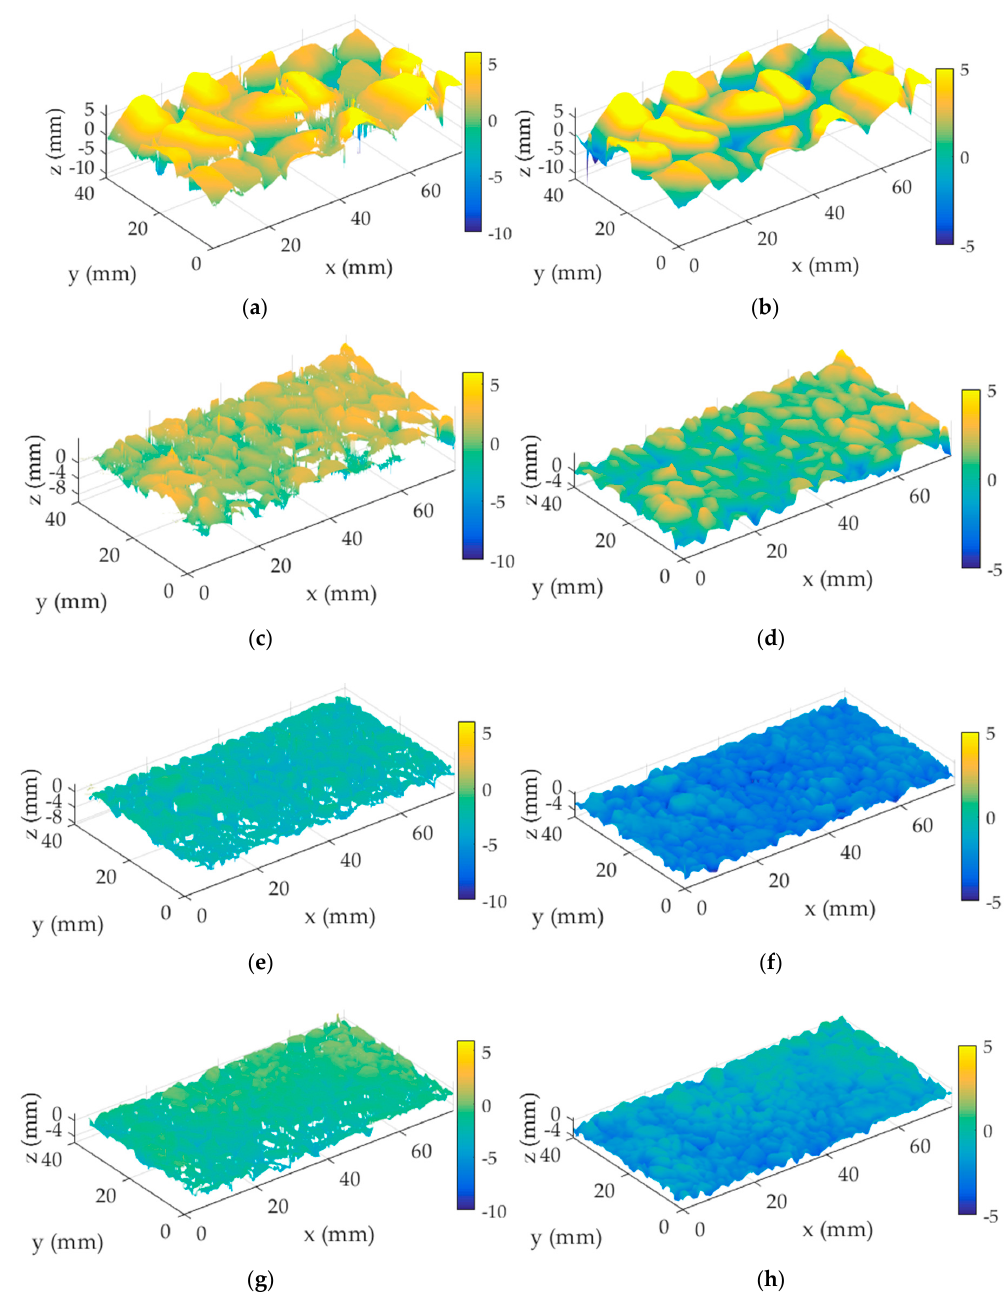
Figure 10. ( a–g ) Original models for samples 1 – 4; ( b–h ) their reconstruction